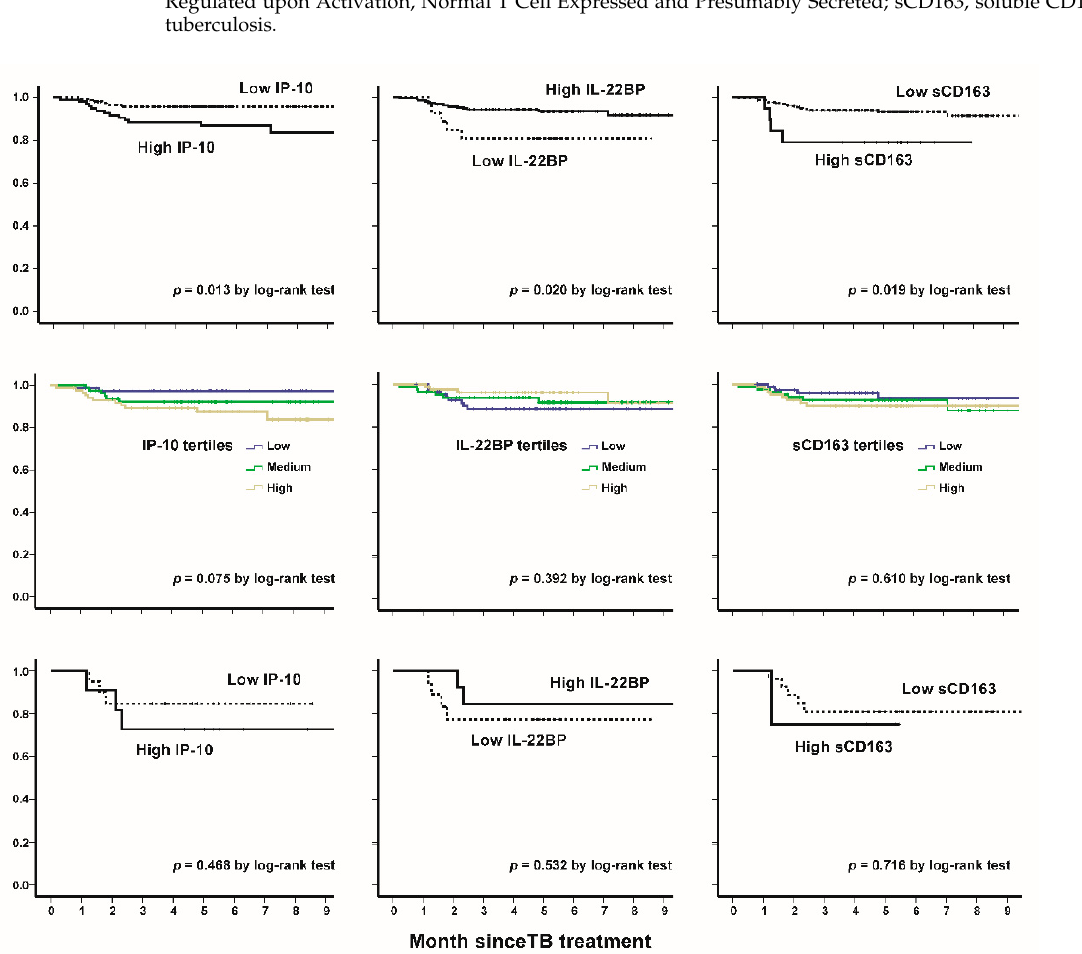
Figure 3. DILI-free survival curves, stratified by IP-10, IL-22BP, and sCD163 levels ( upper panel ); in tertiles ( middle panel ), Figure 3. DILI ‐ free survival curves, stratified by IP ‐ 10, IL ‐ 22BP, and sCD163 levels (upper panel); in tertiles (middle panel), and in the HBV subgroup ( lower panel ), and in the HBV subgroup (lower panel), respectively. Table 4. Patient characteristics, stratified by IP ‐ 10, IL ‐ 22 BP, and sCD163 levels.